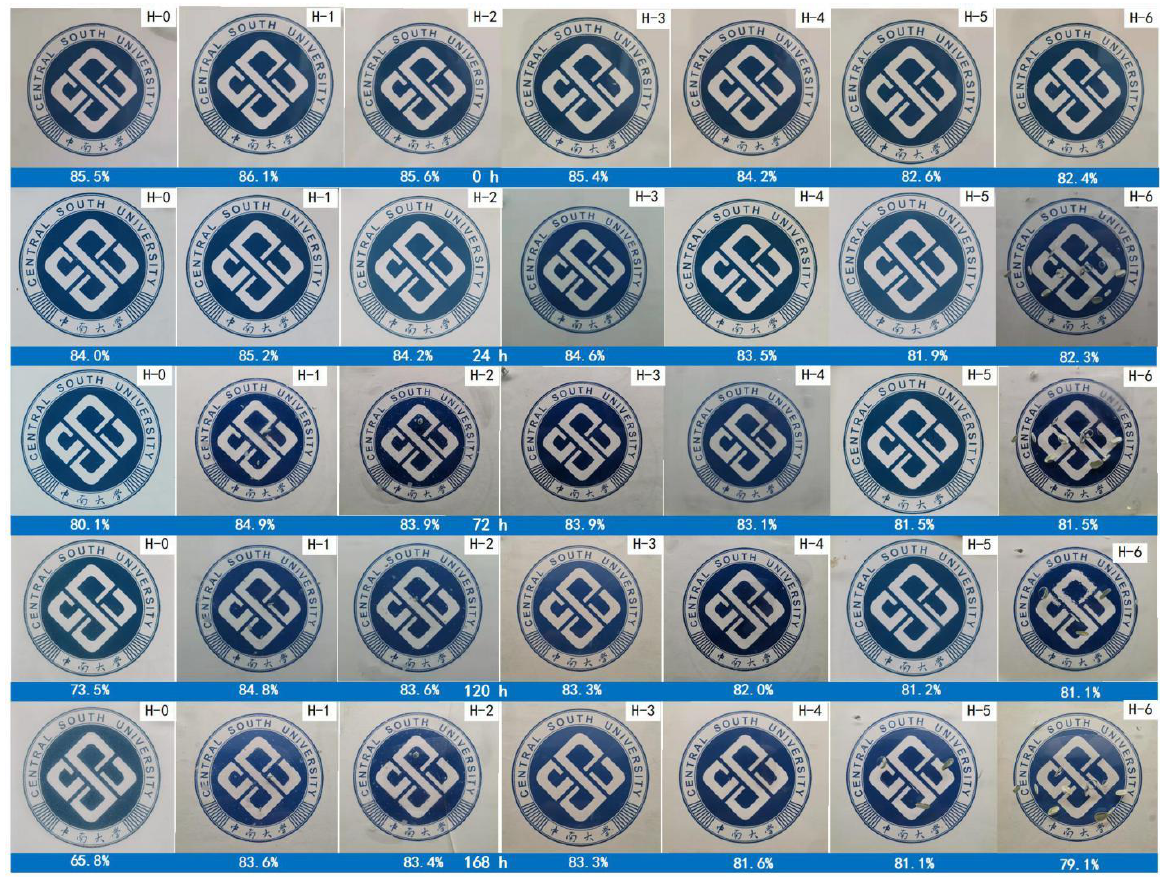
Figure 10. Digital photos and light transmittance of samples during accelerated ageing test.